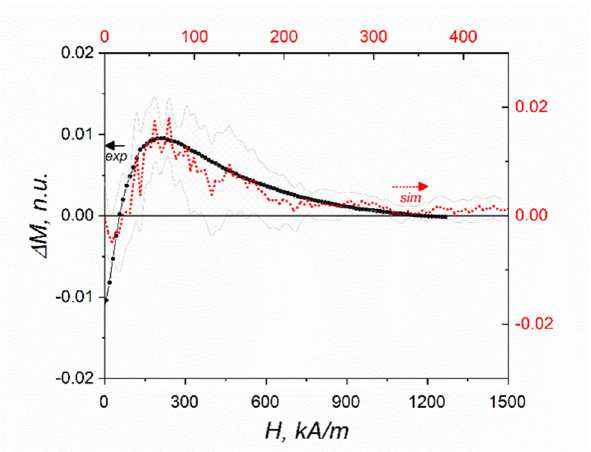
Figure 6. Magnetization increment Δ𝑀(𝐻) = 𝑀(𝐻) (cid:3006) − 𝑀(𝐻) (cid:2868) , normalized units under an electric bias of 5 MV/m; experimental data (black) and simulation data (red) with error bars (grey).